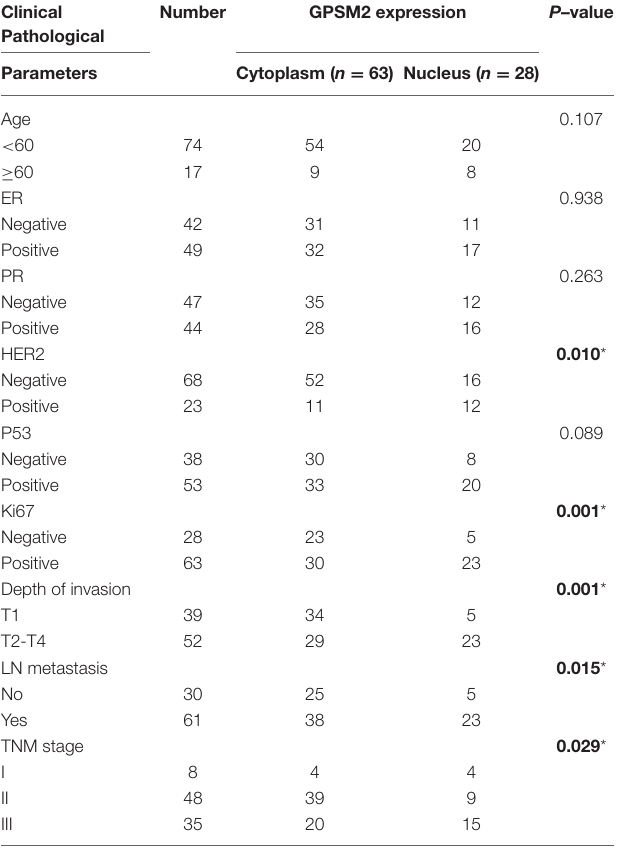
TABLE 2 | Correlation between GPSM2 subcellular localization and clinical characteristics in breast cancer patients ( n = 91).